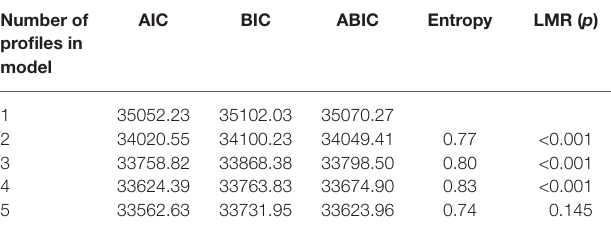
TABLE 2 | Latent profile models ( n = 1,075).